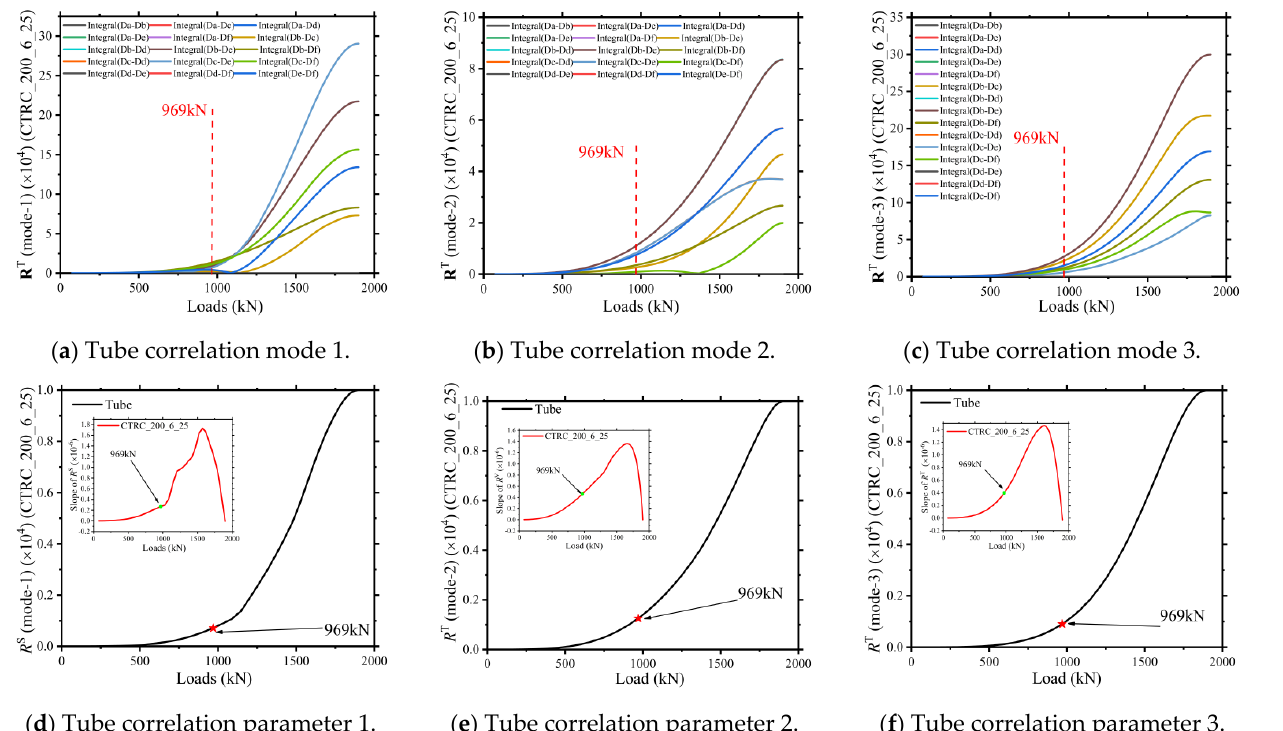
Figure 7. Tube characteristic pairs of CTRC_200_6_25.